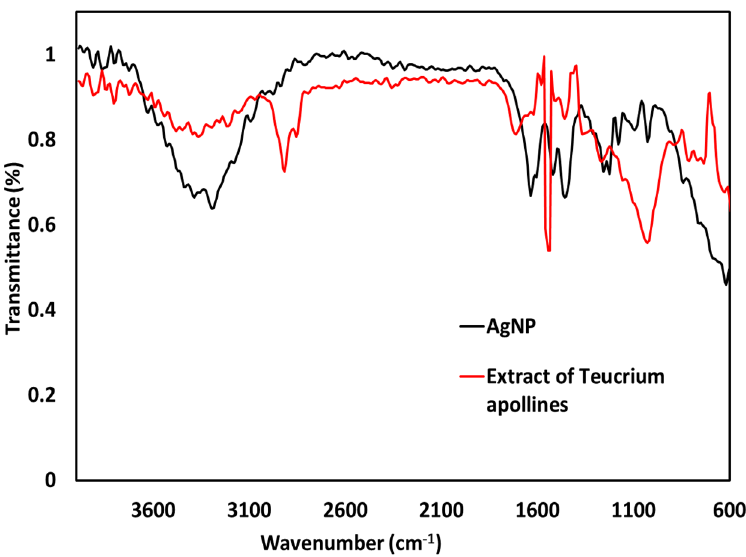
Figure 6. Comparison between extract of Teucrium and AgNP functionalized by the same extract.